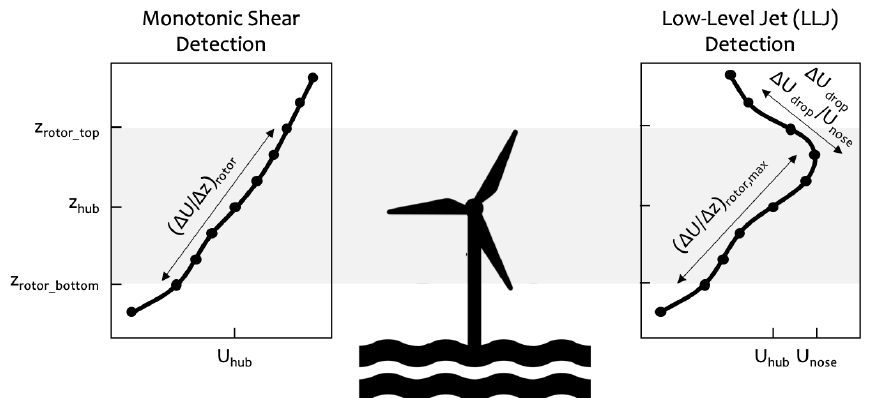
Figure 3. Schematic showing key quantities used in the algorithm developed to detect the two types of high-shear profiles considered herein: monotonic shear and low-level jet (LLJ). Individual detections are then merged into events.